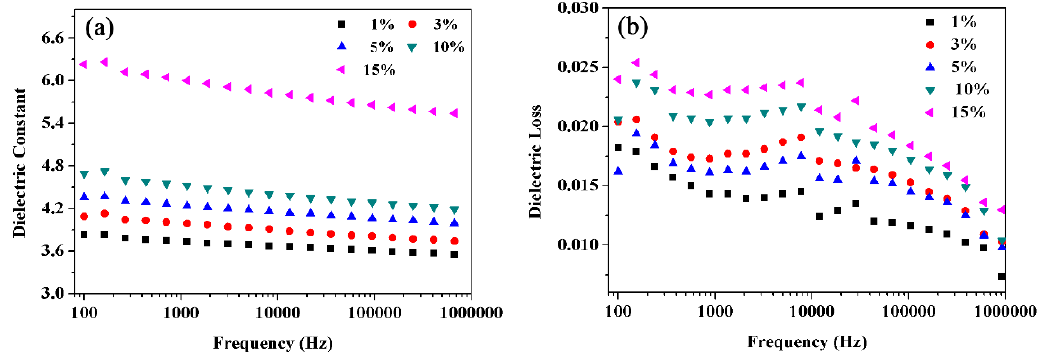
Figure 7. Dielectric constant ( a ) and dieledctric loss ( b ) of PEN composites with 1, 3, 5, 10 and 15 wt % of BT@ZnPc-GO-1.